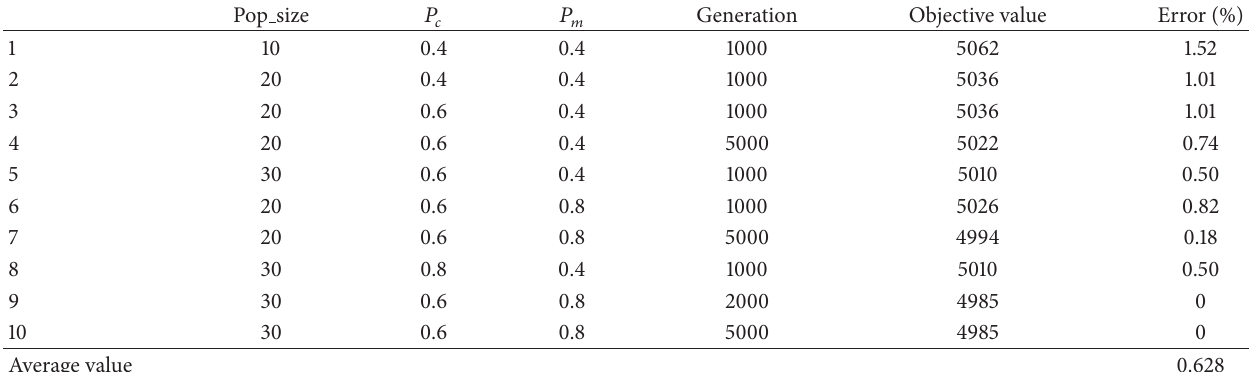
Table 9: The comparison of the optimal